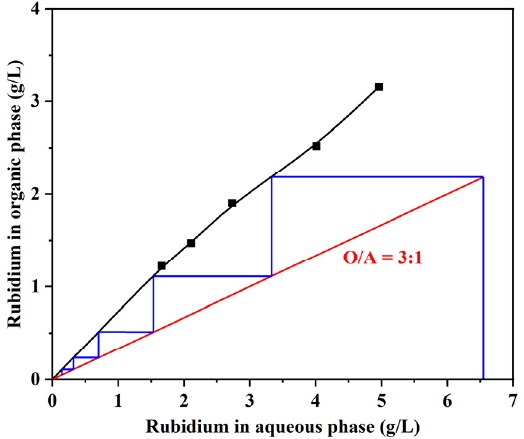
Figure 2. Extraction isotherm of Rb.